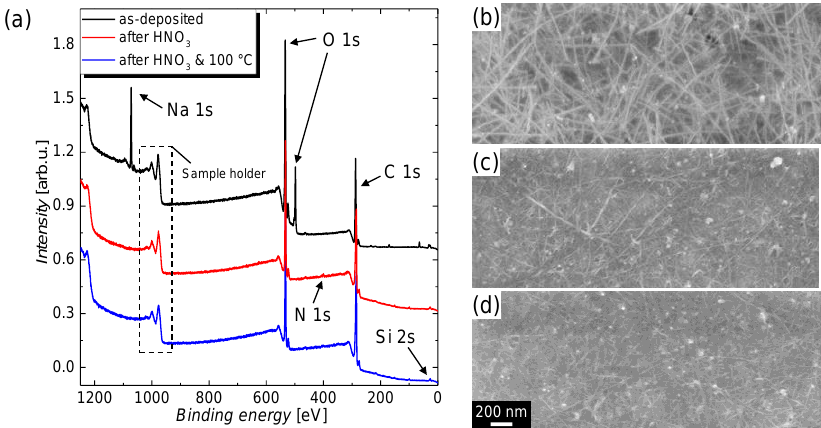
Figure 1. ( a ) X-ray photoelectron spectroscopy (XPS) survey scans of (top black curve) an as-deposited carboxymethyl cellulose (CMC)-carbon nanotube (CNT) film (treatment I), (middle red curve) a CMC-CNT film after immersion in HNO 3 (treatment II), and (bottom blue curve) a CMC-CNT film after treatment II followed by thermal annealing at a temperature of 100 °C (treatment III). The peaks that are associated with the different elements are indicated in the spectra. Scanning electron microscope (SEM) images recorded for CMC-CNT films subjected to the treatments ( b ) I, ( c ) II. and ( d ) III. The scale bar in ( d ) applies to all SEM images.